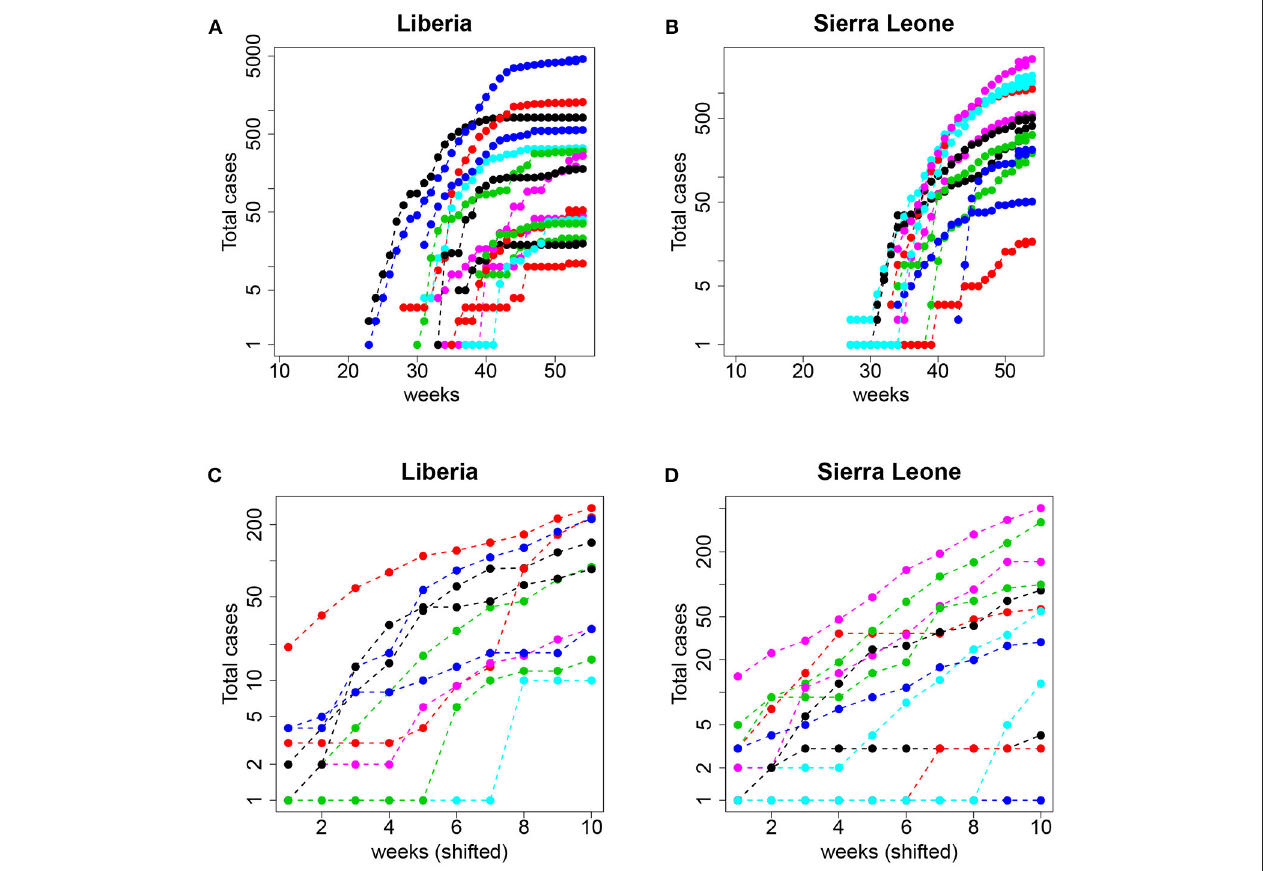
FIGURE 9 | Top: Total number of cases (logarithmic scale) per county in (A) Liberia and (B) Sierra Leone. Bottom: The same but aligning week 1 to the date of the first event with I ≥ 1 and restricting to the first 10 observations (see text for details); (C) Liberia and (D) Sierra Leone.